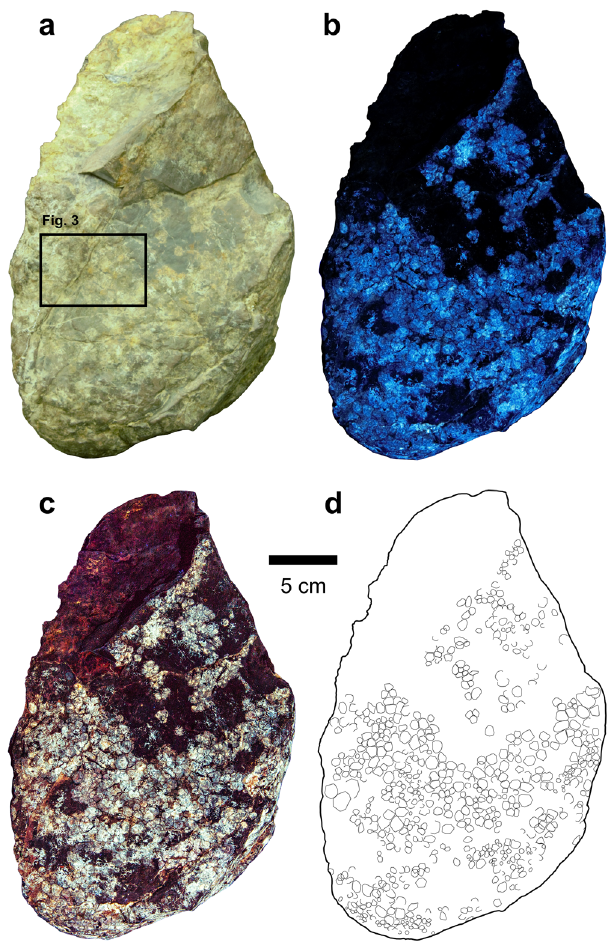
Fig. 2 ‘ Side B ’ of NHMUK R1868, showing relatively small, fl attened, subrounded or polygonal scales (quadrangular – octagonal). Photographs under a white light and b , c laser-stimulated fl uorescence. d Interpretive outline drawing. Scale bar for all parts as indicated.